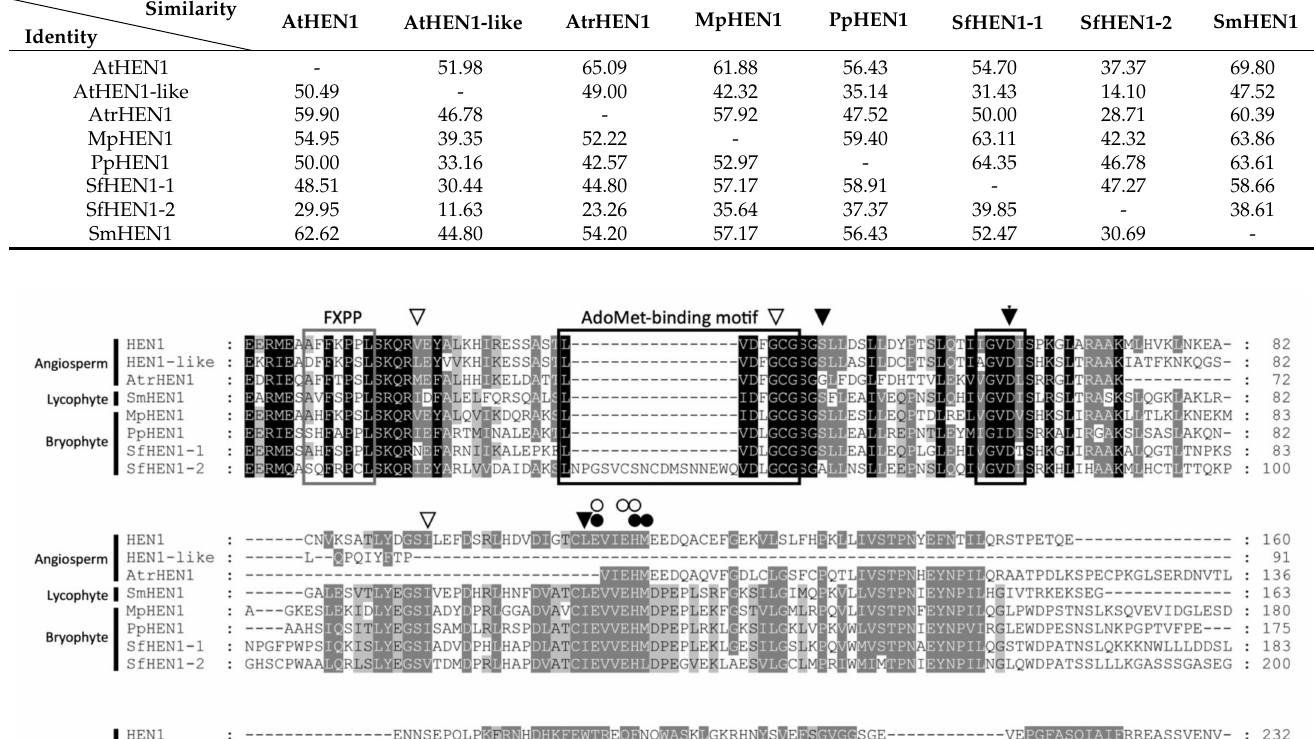
Table 1. The similarity and identity of the MTase domains of plant HEN1 orthologs.